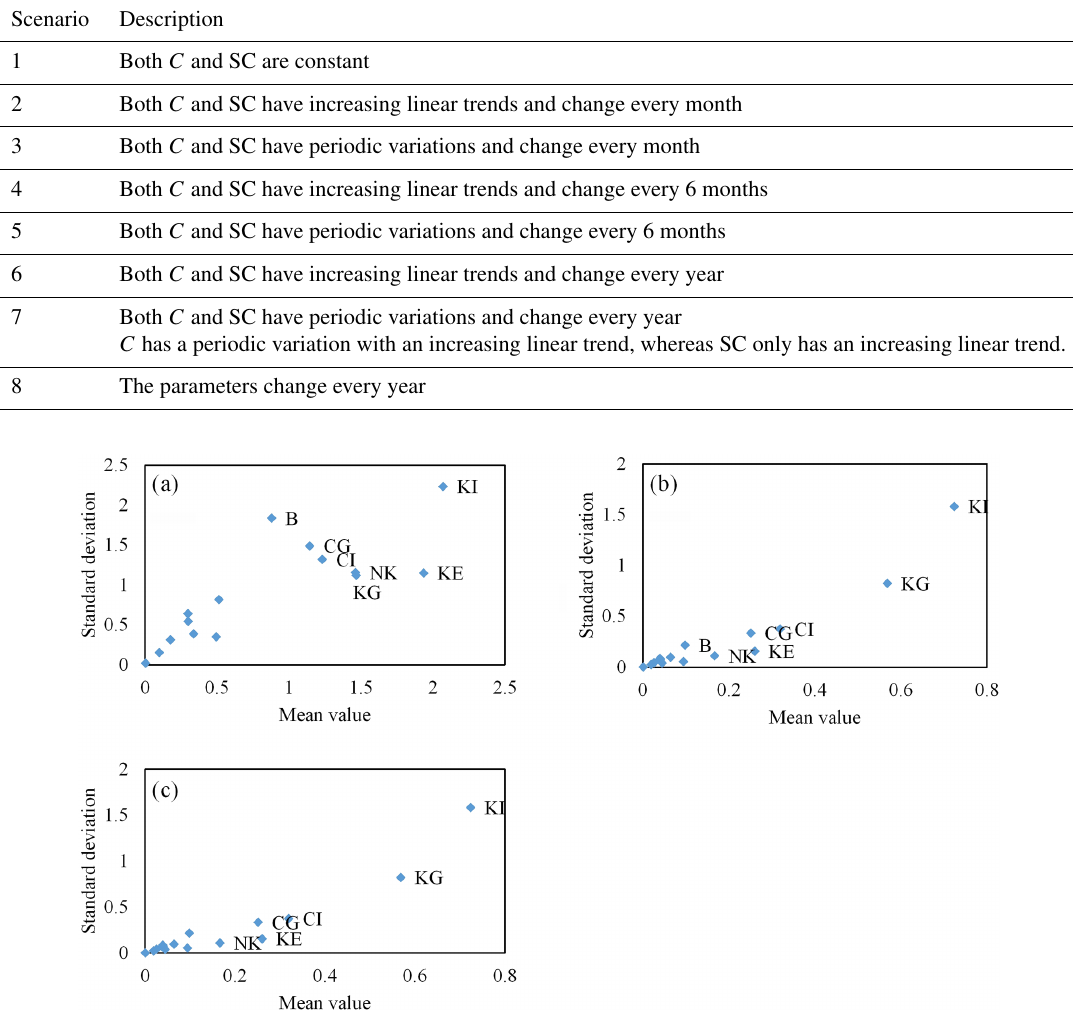
Table 4. True parameters of different scenarios in the synthetic experiment with the TMWB model.